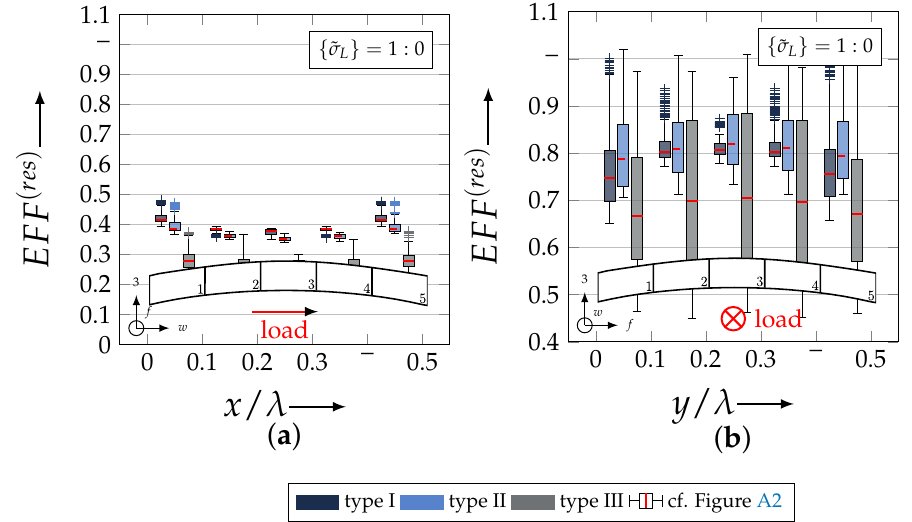
Figure 23. Illustration of resultant stress effort EFF ( res ) per defined normalised section according to Figure 13a at load ratio { ˜ σ L } = 1:0 for ( a ) weft and ( b ) fill yarn.